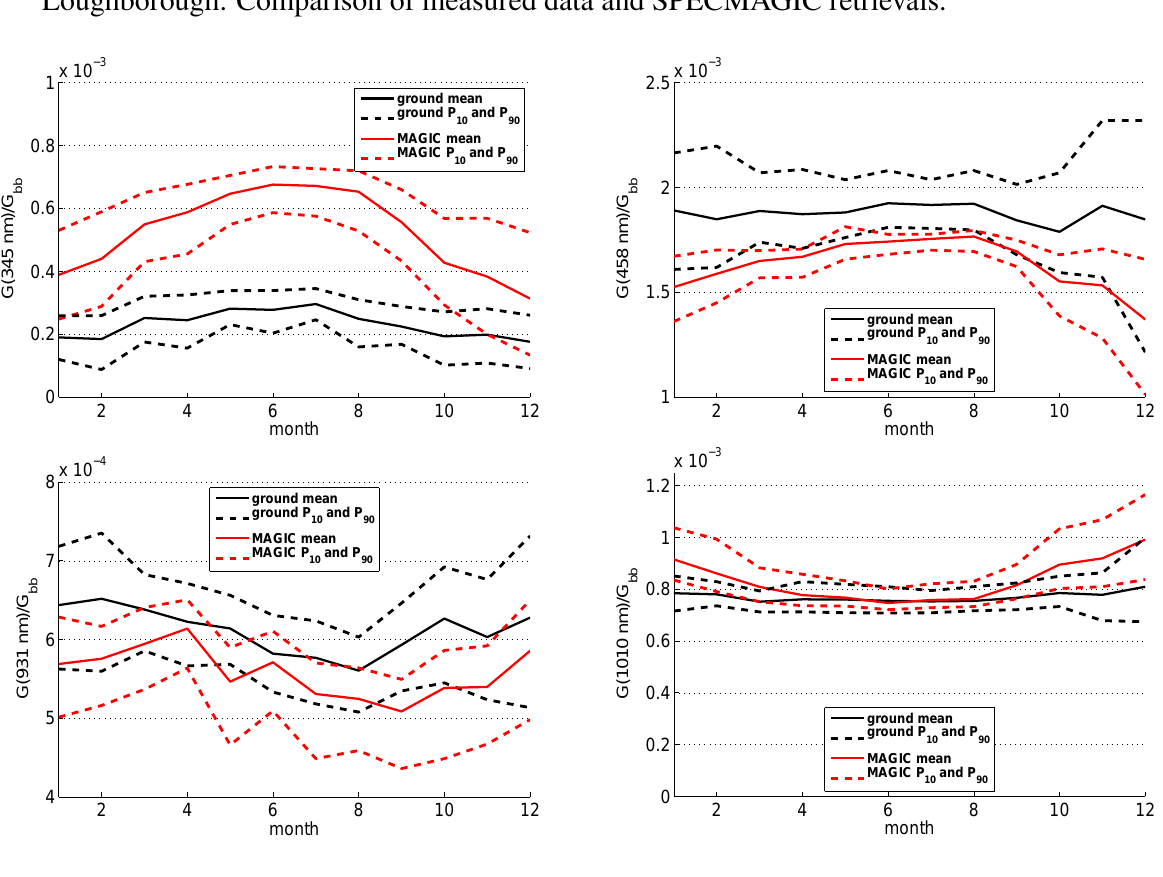
Figure 10. Annual course of normalized irradiance for four wavelength bands for Loughborough. Comparison of measured data and SPECMAGIC